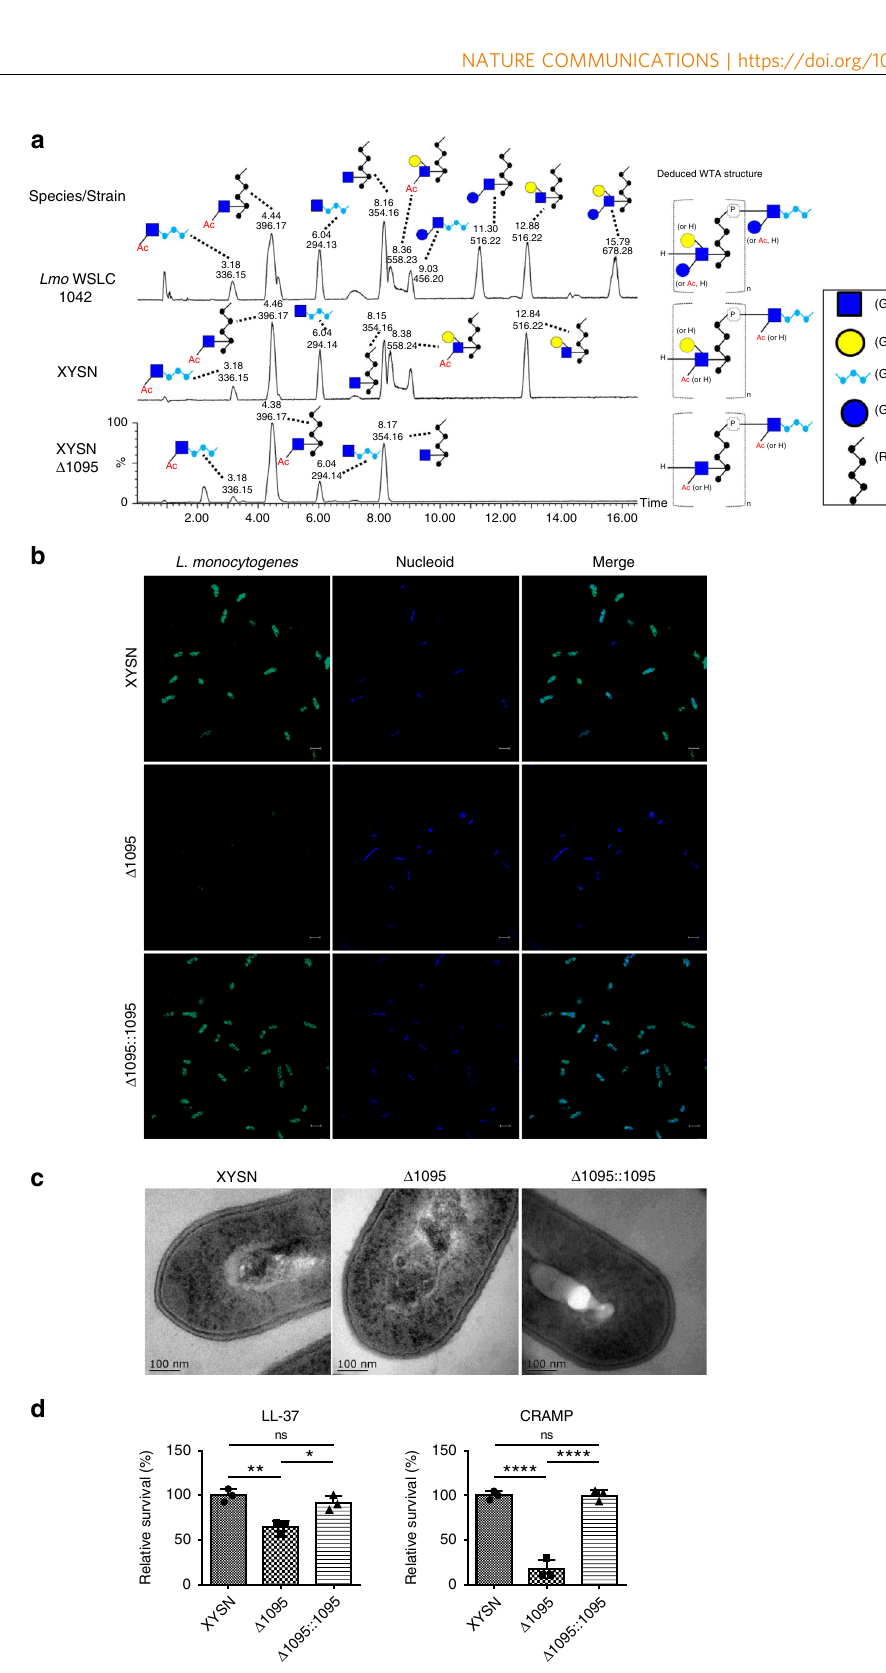
lacking the smcL gene, a decrease of ~1.6-fold in the invasion ability of the bacterium was observed (Fig. 7b). Introduction of smcL gene into EGD-e and NTSN increased the ability of these bacteria to invade the epithelial cell by at least twofold (Fig. 7c). Hence both hly and smcL promote entry of XYSN in human- derived intestinal epithelial